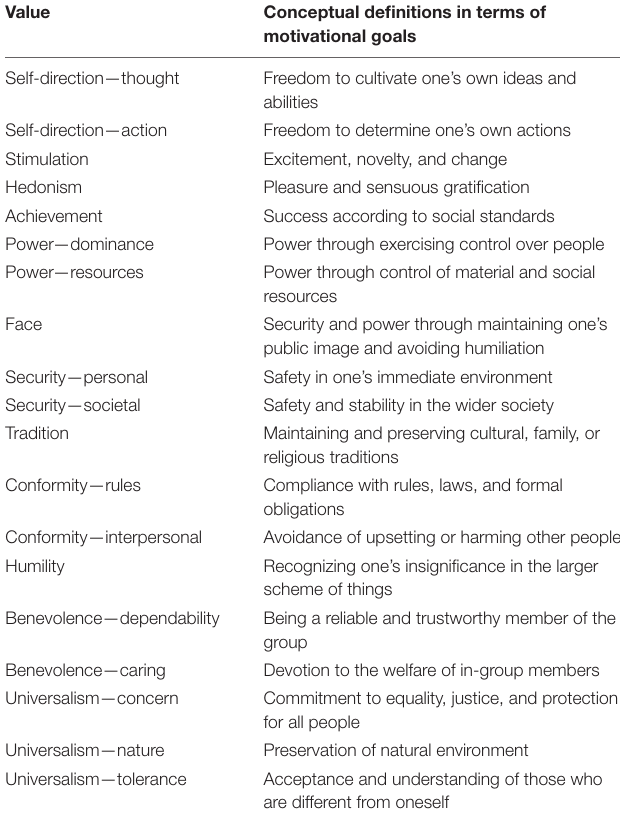
TABLE 1 | Basic human values and their conceptual